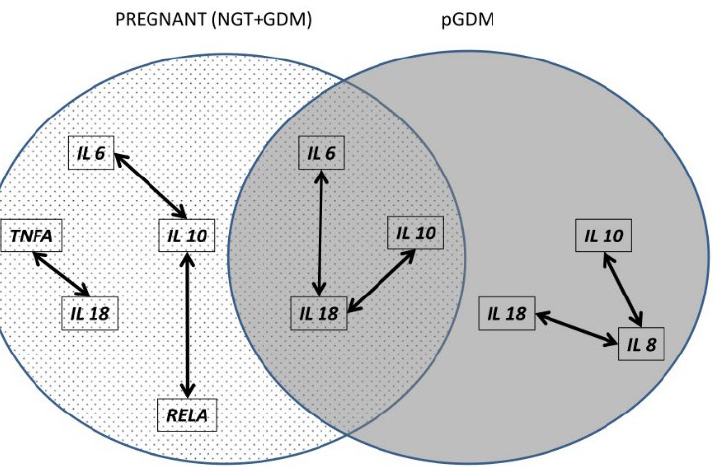
Figure 3. Scheme illustrating distinct and overlapping sets of gene–gene positive correlations through- out pregnancy and 1 year after delivery.